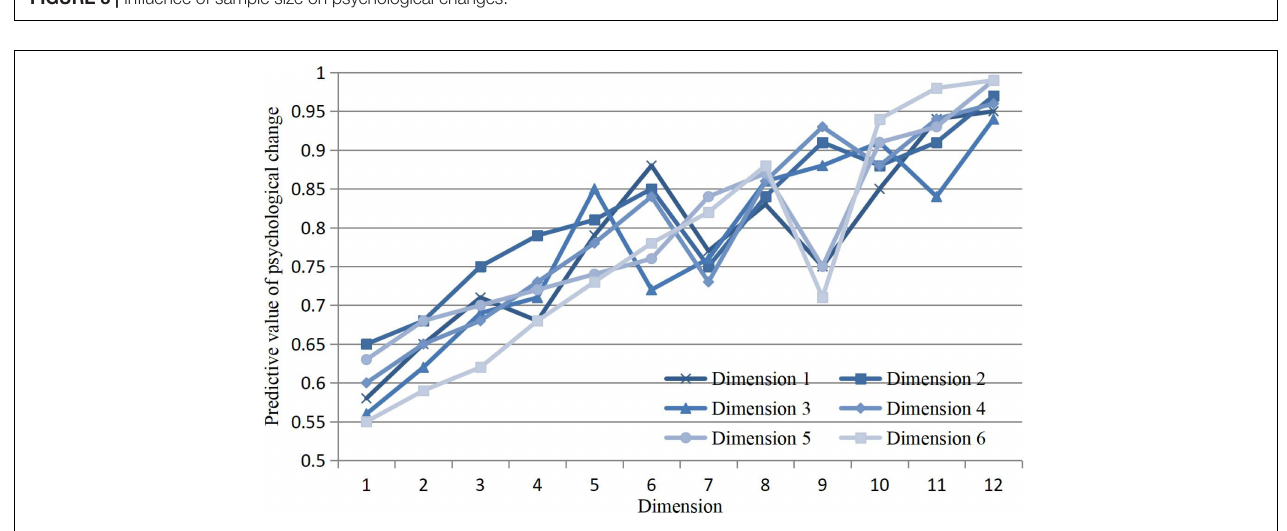
FIGURE 3 | Influence of sample size on psychological changes.